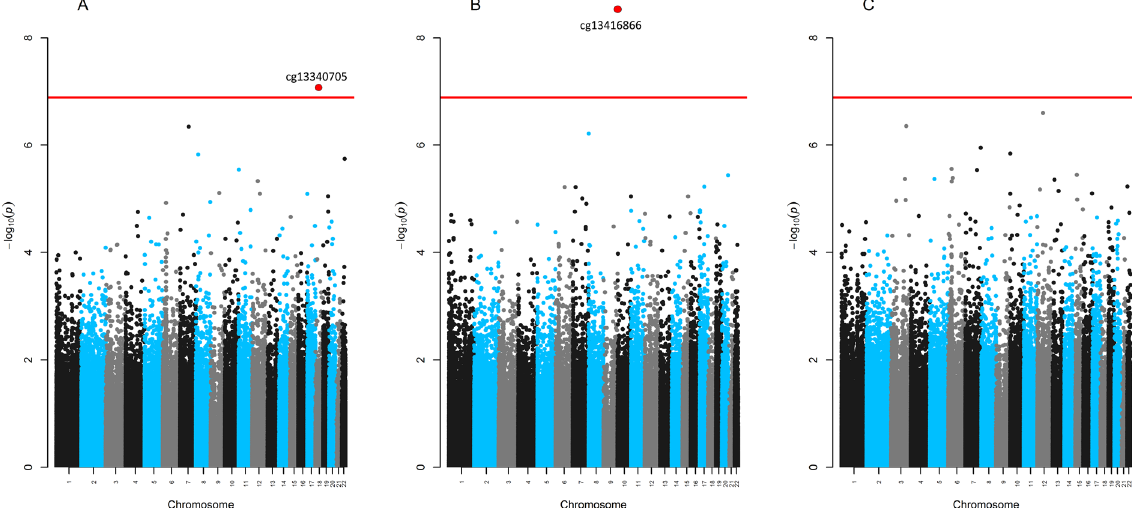
Figure 5. Manhattan plots for the epigenome-wide association of prenatal mercury exposure and individual CpG methylation levels: ( A ) Overall analysis ( B ) males-specific analyses and ( C) female-specific analyses (red solid line represents the Bonferroni adjusted level of significance).